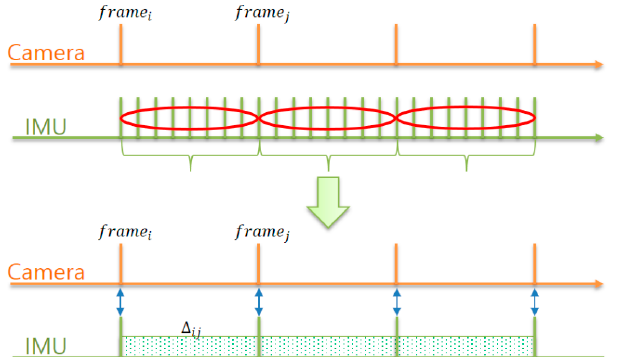
Figure 3. Diagram of the IMU preintegration method.